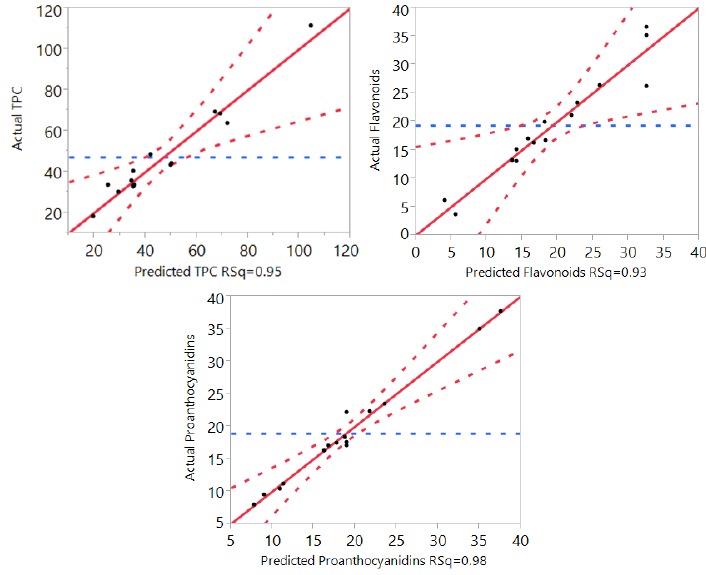
Figure 2. The correlation between the predicted and the actual values for TPC, flavonoids, and proanthocyanidins. The values ( Y ) for phenolic compounds, flavonoids and proanthocyanidins from the macadamia skin could be fitted to the below second-order polynomial Equations (3)–(5):